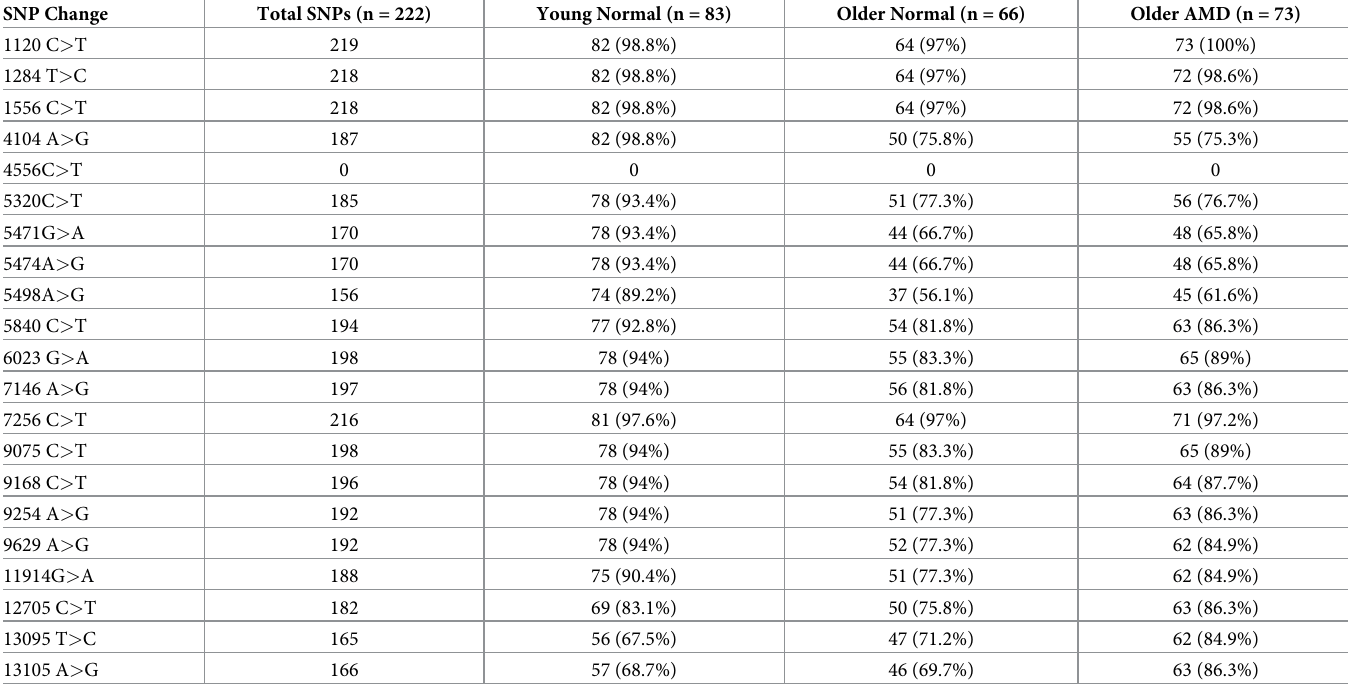
Table 8. mtDNA heteroplasmy 23 hot-spots found in blood of 222 subjects.